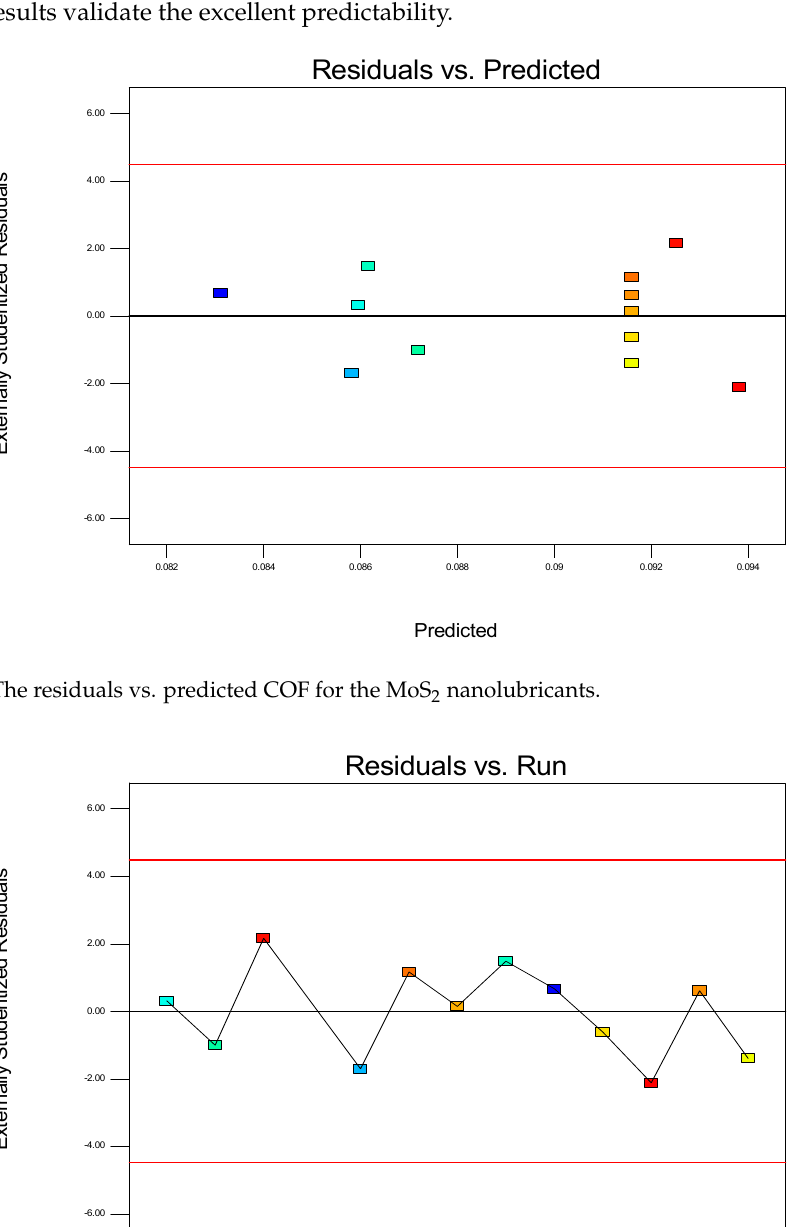
Figure 4. A contour interaction plot of the COF for the MoS 2 nanolubricants.